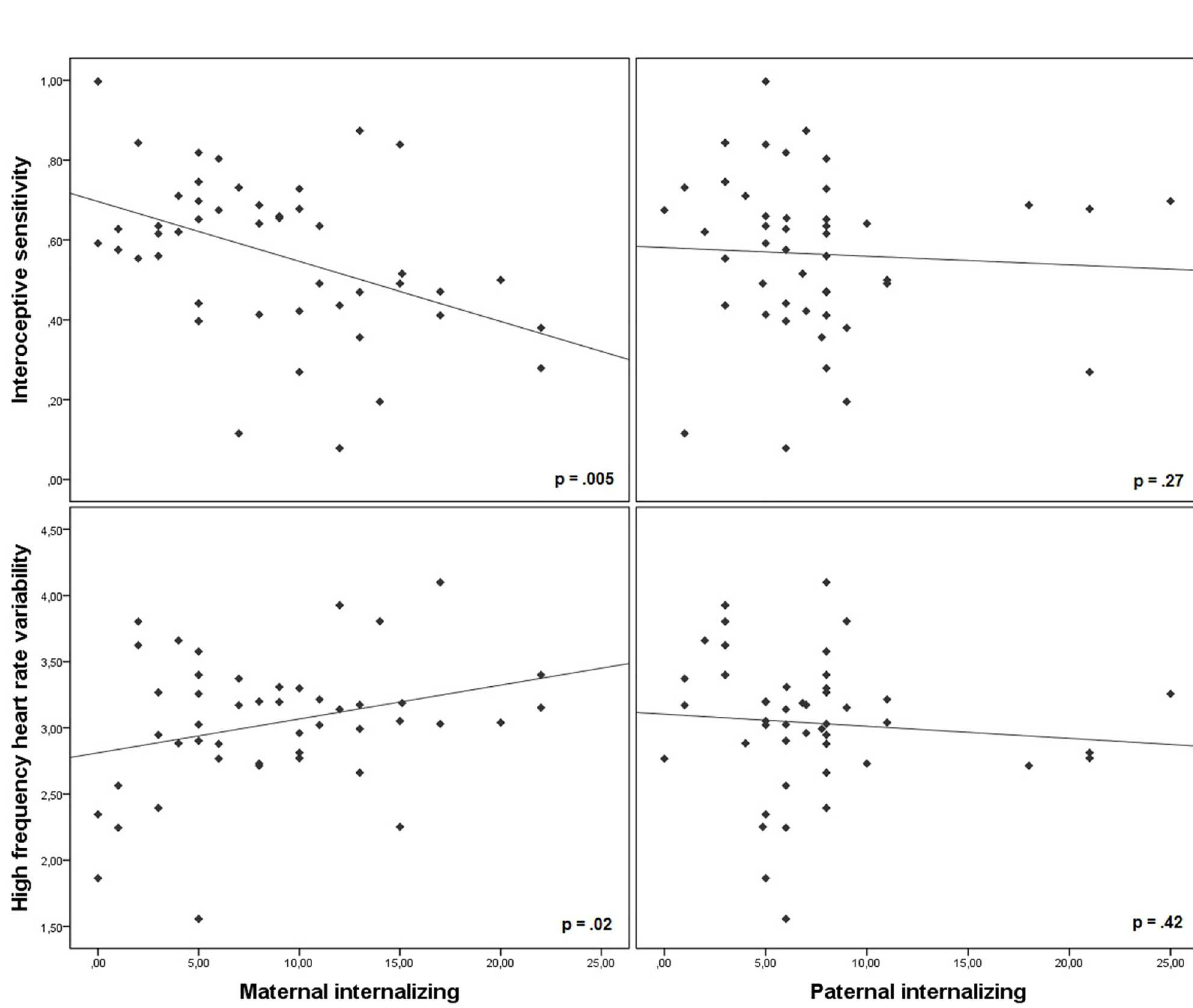
Fig 1. Scatterplots depicting the significant correlations between parental internalizing symptoms and interoceptive sensitivity and heart rate variability (high frequency component) in the child. While maternal internalizingsymptoms were correlated with child autonomic components (left panes), this effect was absent for paternal internalizing symptoms (right panes). Bivariate correlationsare shown for the purposeof clear visualization and